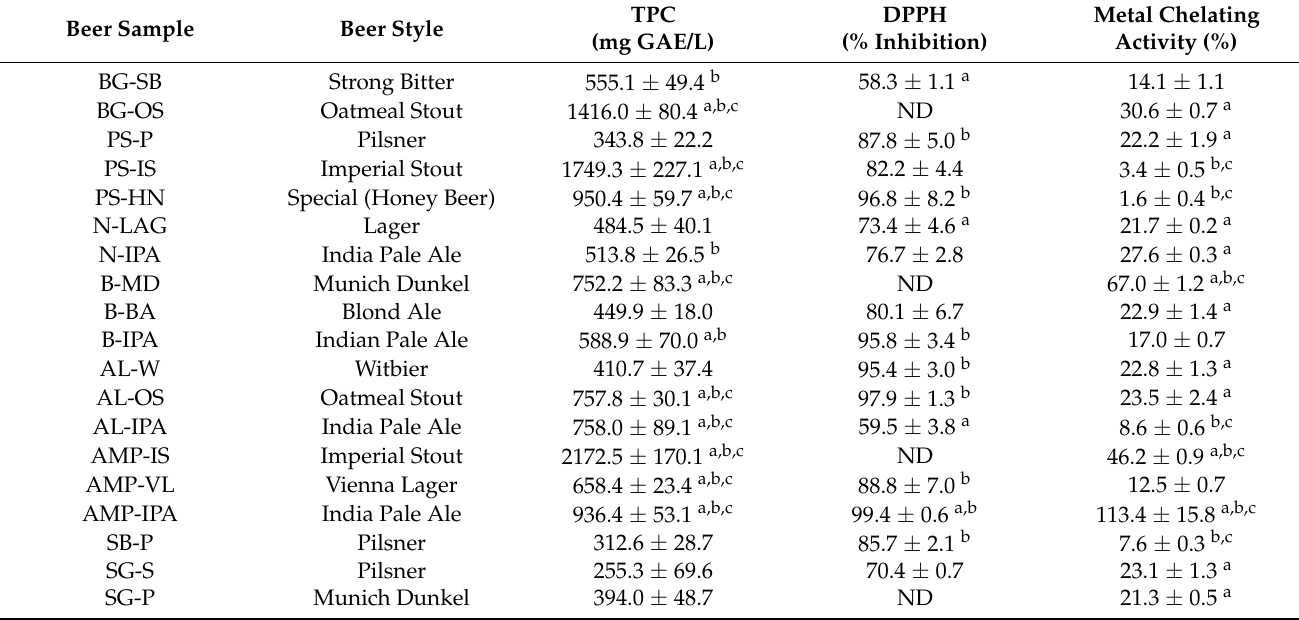
Table 2. Phenolic content, DPPH radical scavenging activity and metal chelating activity in analyzed